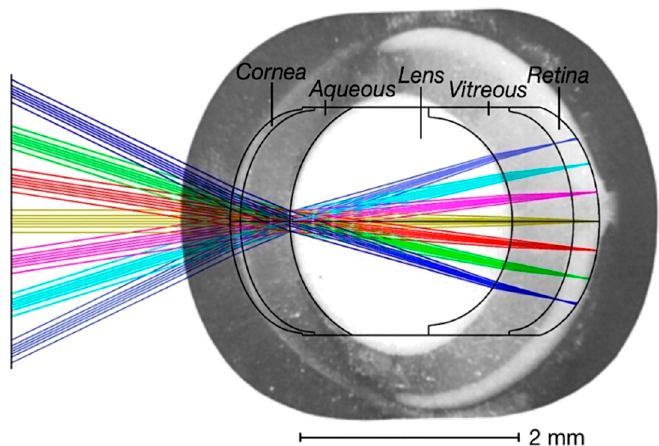
Figure 10. Optical model (Zemax) overlaid with mouse eye cross-section. Incident collimated light focuses on the retina.